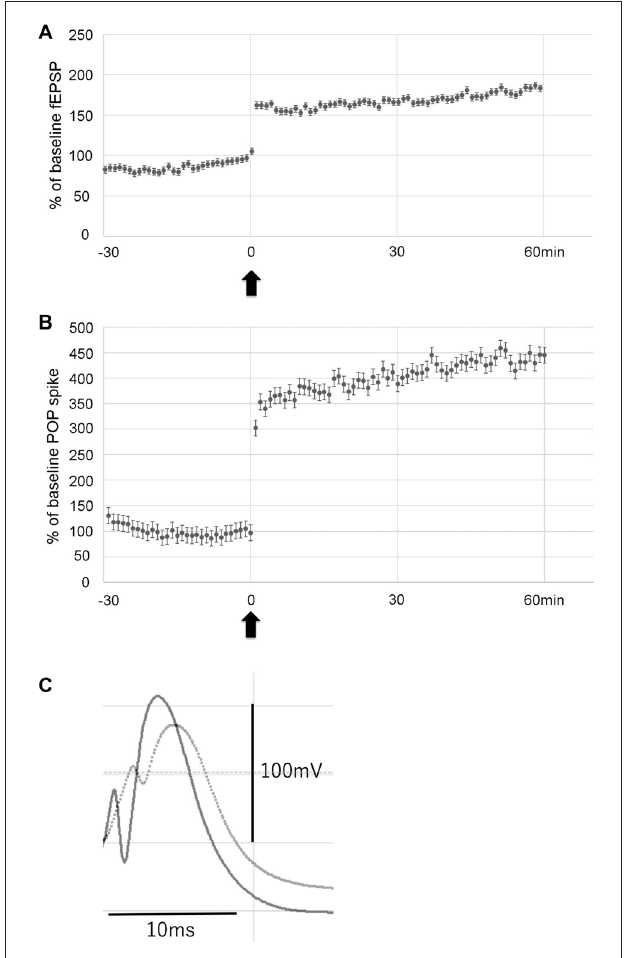
FIGURE 3 | Data showing the mean field excitatory postsynaptic potential (fEPSP) slope ( ± standard deviation, SD) and the mean POP spike ( ± SD) as a percentage of baseline. Rats in the LTP(+) group ( N = 6) showed stable potentiation throughout post-HFS baseline recording, as measured by both fEPSP slope (A) and POP spike (B) . Arrow indicates delivery of HFS. Error bars indicate SD. Evoked potentials recorded before (dotted line) and after LTP (solid line) are shown (C) .